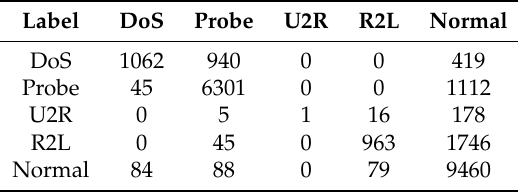
Table 12. Confusion matrix of I-ELM.